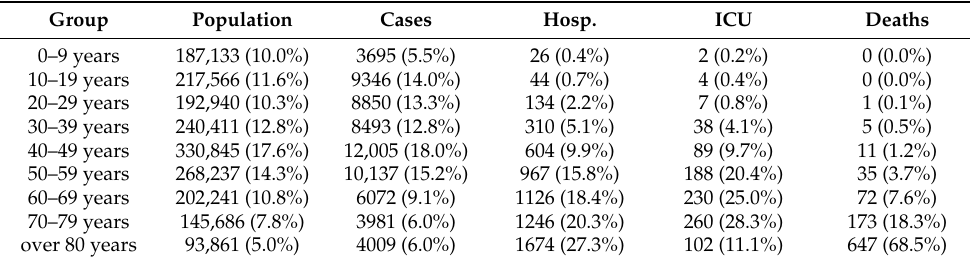
Table 1. Percentage of cases by age group, in the absence of the effect of the vaccine (epidemiological data 1 September–31 December 2020). North Metropolitan Health Region, Catalonia. Source: DADESCOVID (Catalonia’s official COVID data. https://dadescovid.cat/. Accessed on 29 December 2021).